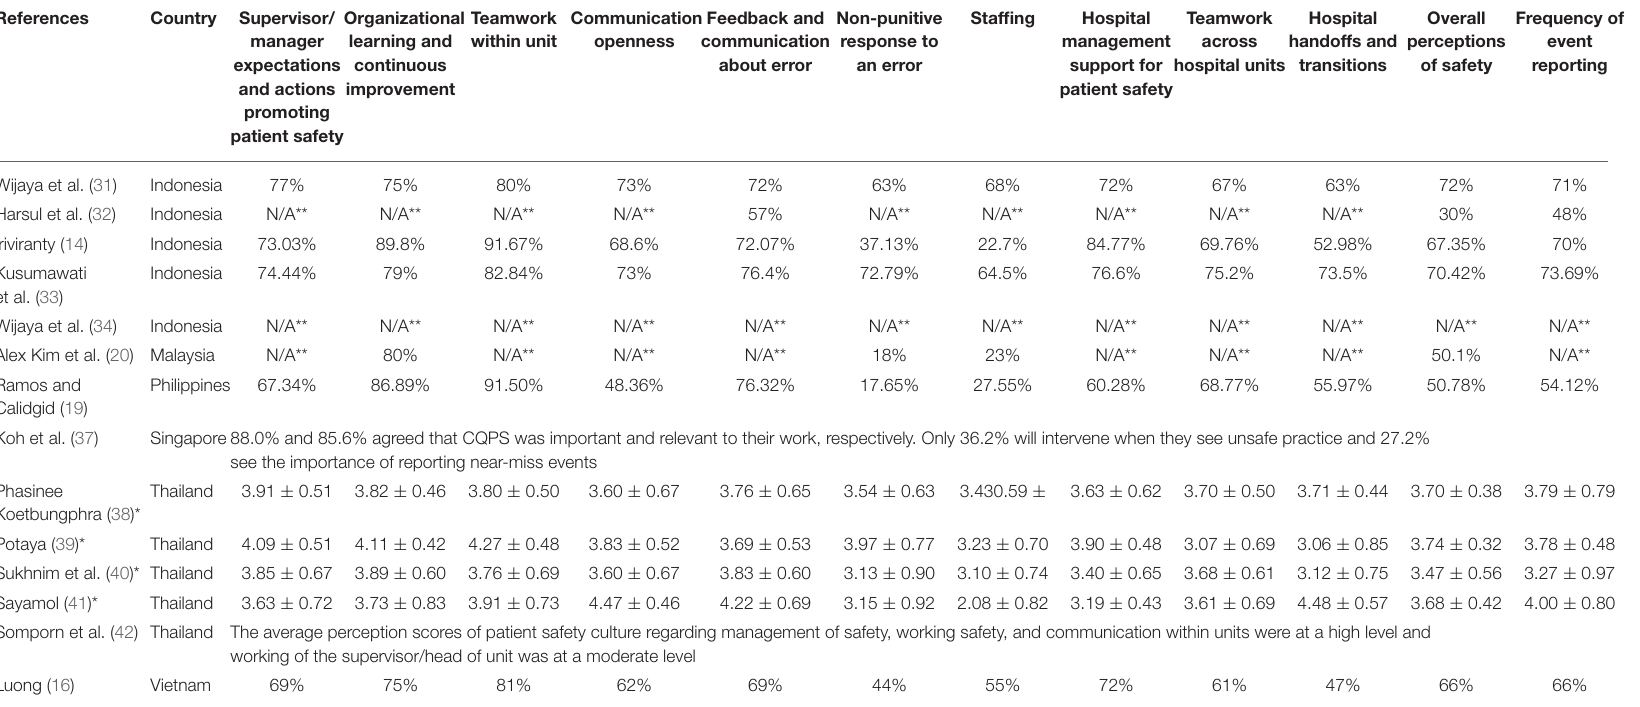
TABLE 2B | The percent-positive scores of dimensions of patient safety culture as measured by the Hospital Survey on Patient Safety Culture ( N =